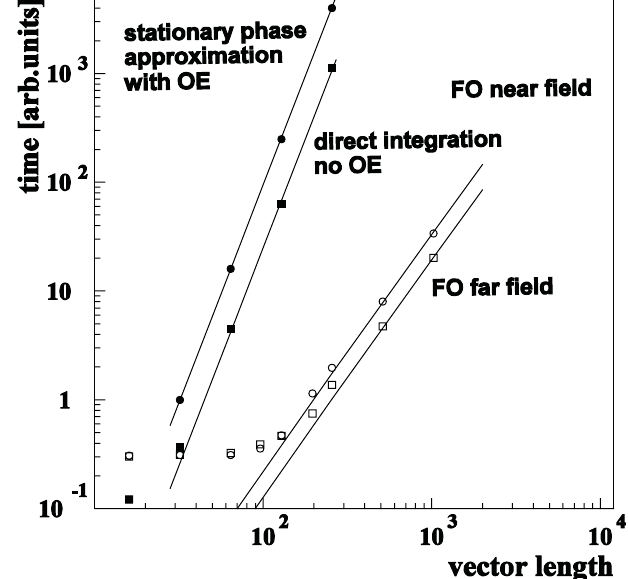
FIG. 10. The CPU time as measured for three free space propagators (Fourier optics propagation: open square and open circle, direct integration of the Fresnel Kirchhoff equation: solid square) and propagation across an optical element using the stationary phase approximation (solid circle). The lines indicate the general scaling behavior as described in